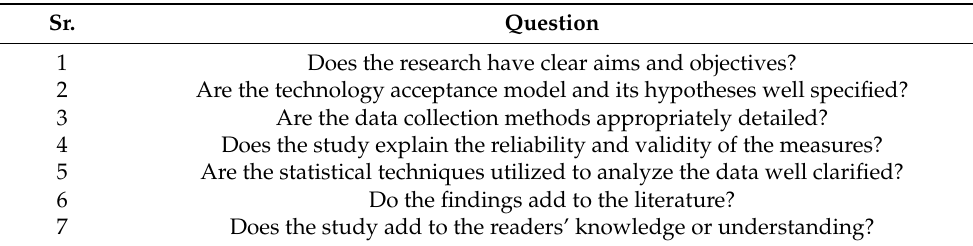
Table 4. Quality assessment checklist.